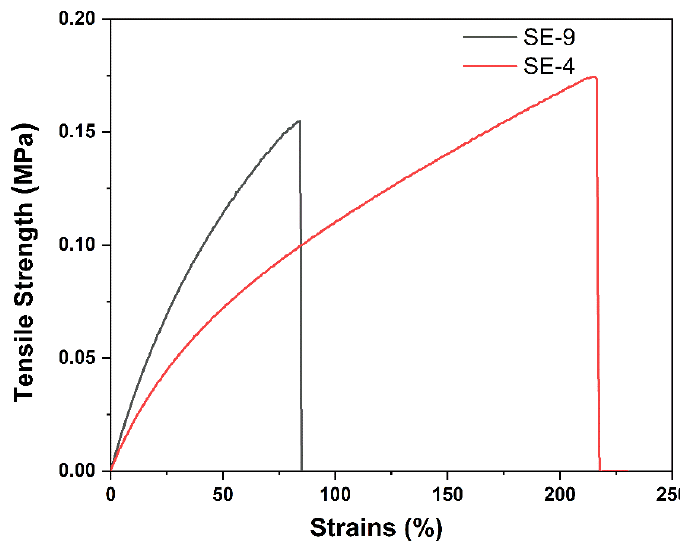
Figure 2. Tensile curves of SE-4 and SE-9.